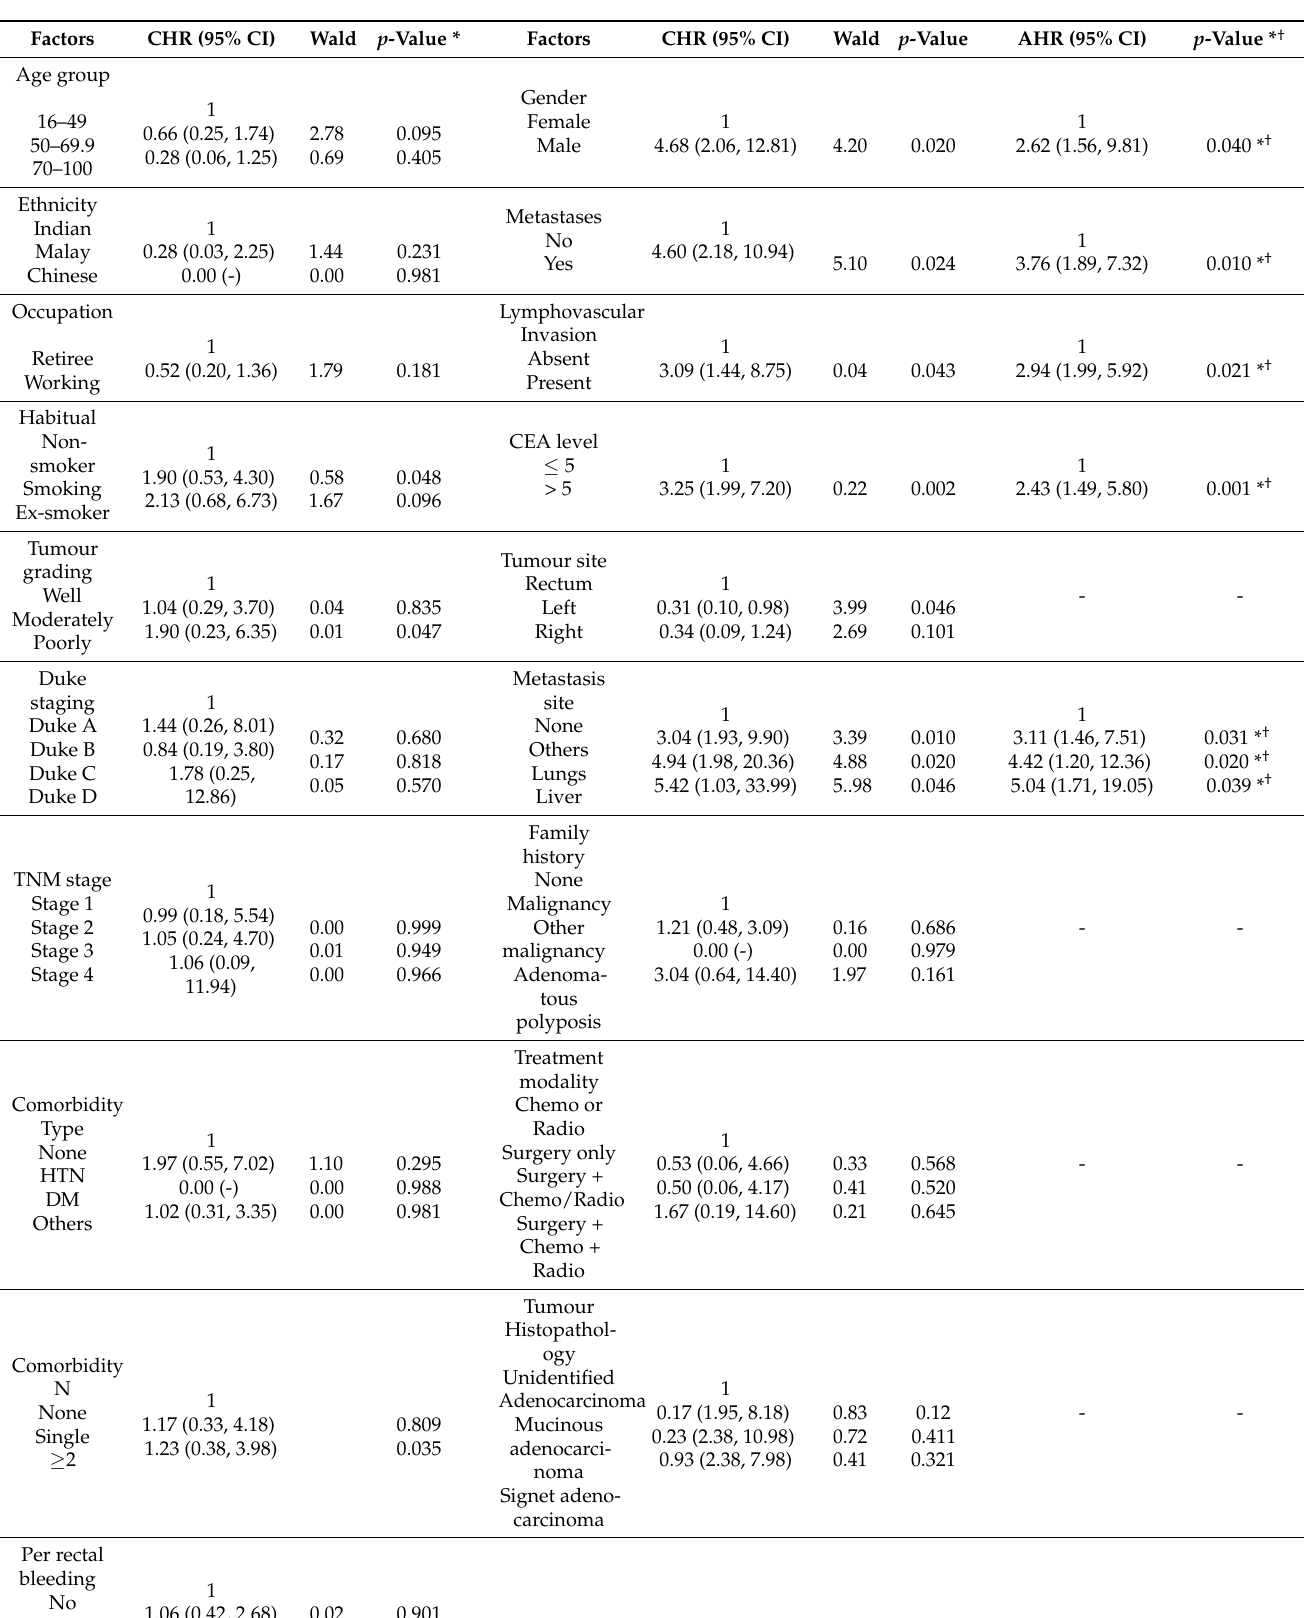
Table 5. Prognostic factors using simple and multiple Cox proportional hazards regression